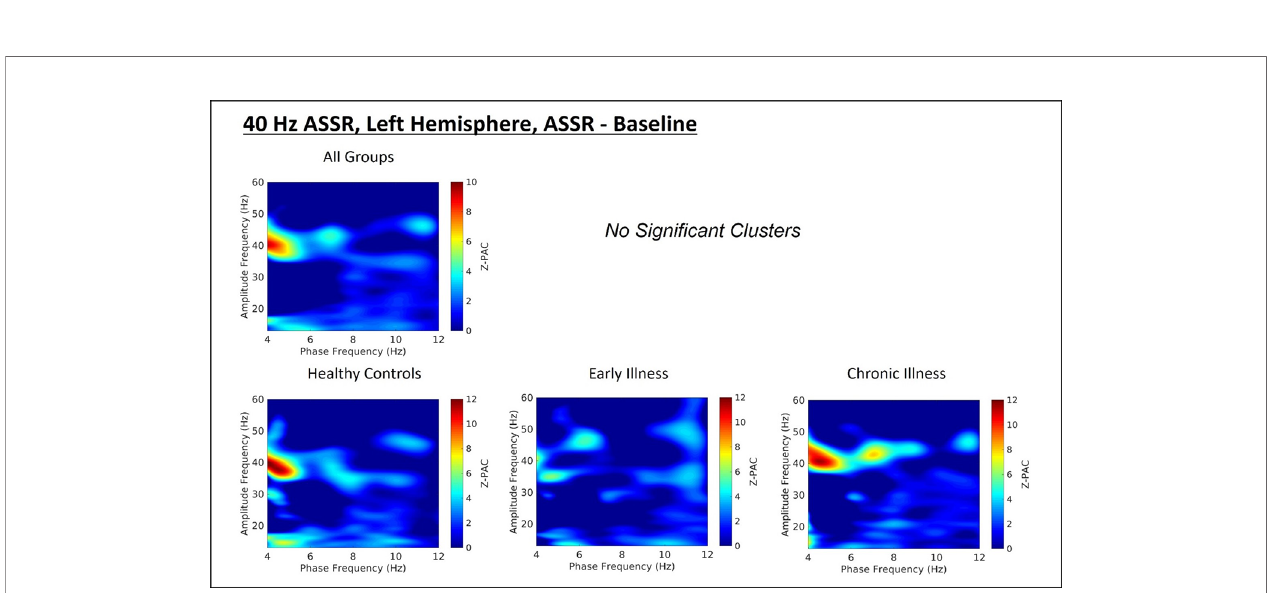
FIGURE 3 | (Top) Left hemisphere Phase-amplitude coupling T-maps demonstrating differences between stimulation and baseline periods of the trial, with subjects pooled across groups. (Bottom) Left hemisphere PAC compared between groups.